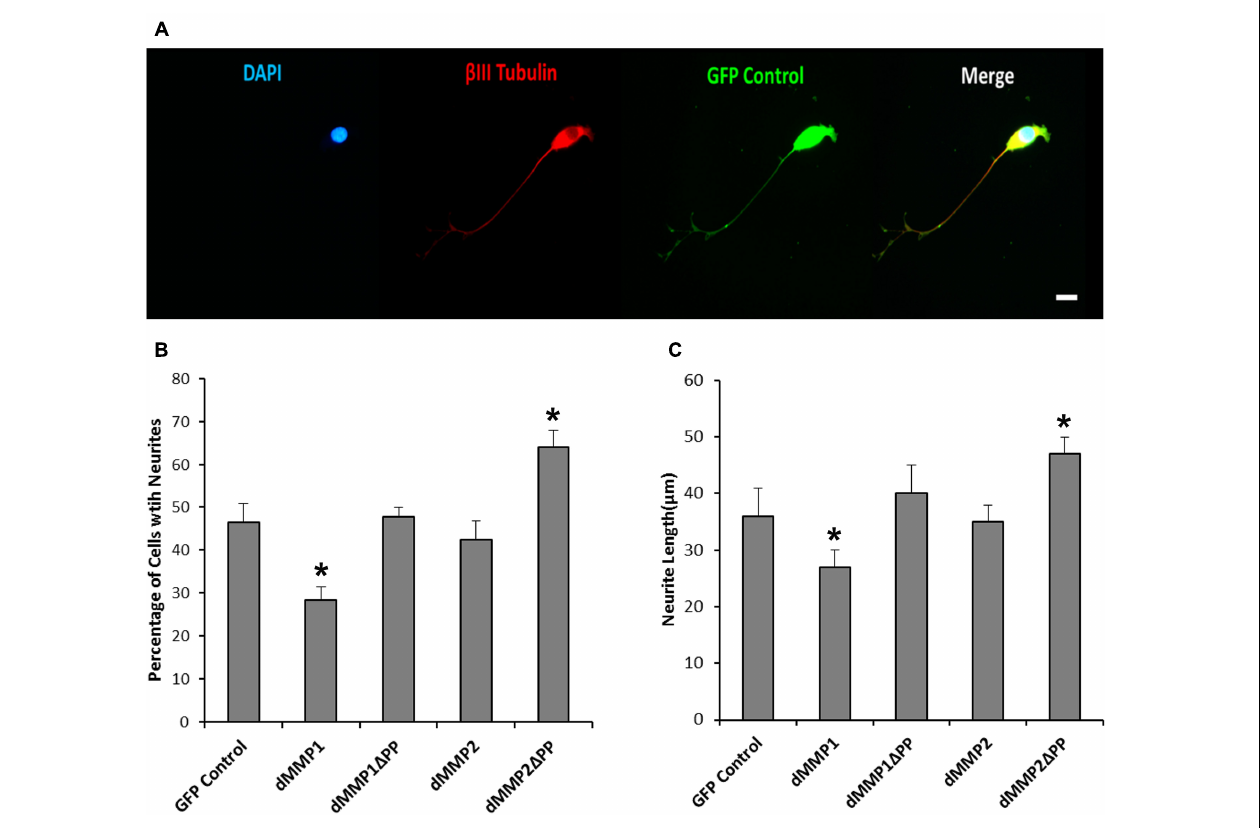
FIGURE 5 | Differential dMMP expression impacts neural differentiation. (A) 12- O -tetradecanoylphorbol-13-acetate (TPA) differentiated stable SH-SY5Y cells expressing GFP. Shown in blue is DAPI nuclear stain, in red is β III Tubulin, and green is GFP. Scale bar = 10 µ m. (B) Percentage of cell with neurite (Mean ± SE) in GFP and GFP-dMMP stable cell lines. (C) Neurite length ( µ m) (Mean ± SE) in GFP Control and GFP-dMMP stable cell lines. Data are averaged across three independent experiments. Bars with * represents significant difference compared to control at p <